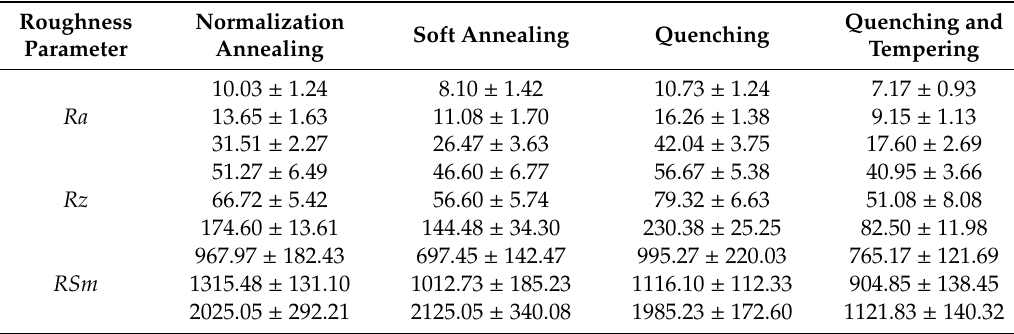
Table 9. Surface roughness characteristics after abrasive waterjet